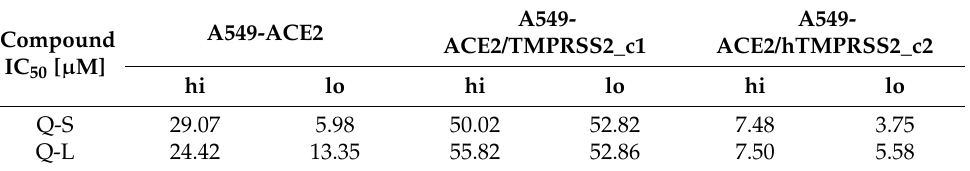
Table 2. IC 50 ( µ M) values of Q-L and Q-S in A549-cells stably expressing ACE2 and TMPRSS2. The IC 50 [ µ M] was calculated with GraphPad Prism (log(inhibitor) vs. response—variable slope (four parameters)). MOI for hi is 1.1 and lo is 0.2.